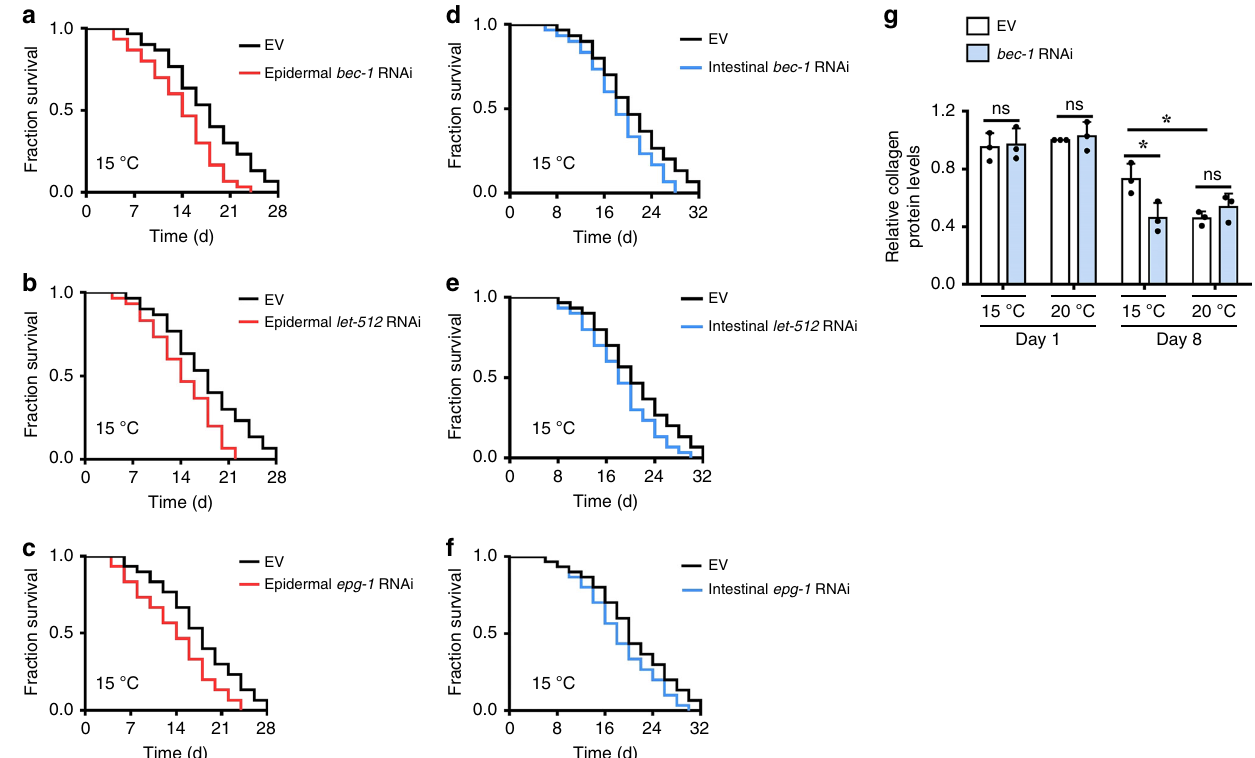
Fig. 5 Autophagy in the epidermis is involved in lifespan extension at low temperature. a – c Epidermal-speci fi c knockdown of bec-1 ( a ), let-512 ( b ), and epg-1 ( c ) by RNAi signi fi cantly reduced the lifespan of worms at 15 °C. P < 0.01 versus EV. d – f Intestinal-speci fi c knockdown of bec-1 ( d ), let-512 ( e ), and epg-1 ( f ) by RNAi did not in fl uence the lifespan of worms at 15 °C. P > 0.05 versus EV. P -values ( a – f ) were calculated using log-rank test. See Supplementary Data 1 for details. g The relative collagen levels in 8-day-old worms at 15 °C were markedly higher than those at 20 °C. Inhibition of autophagy by bec-1 RNAi signi fi cantly reduced the collagen levels in 8-day-old worms at 15 °C. The data are expressed as percent of control (the value of 1-day-old worms at 20 °C). These results are means± SD ( n = 3). * P < 0.05, 8-day-old worms with EV at 15 °C versus 8-day-old worms with EV at 20 °C, or 8-day-old worms with